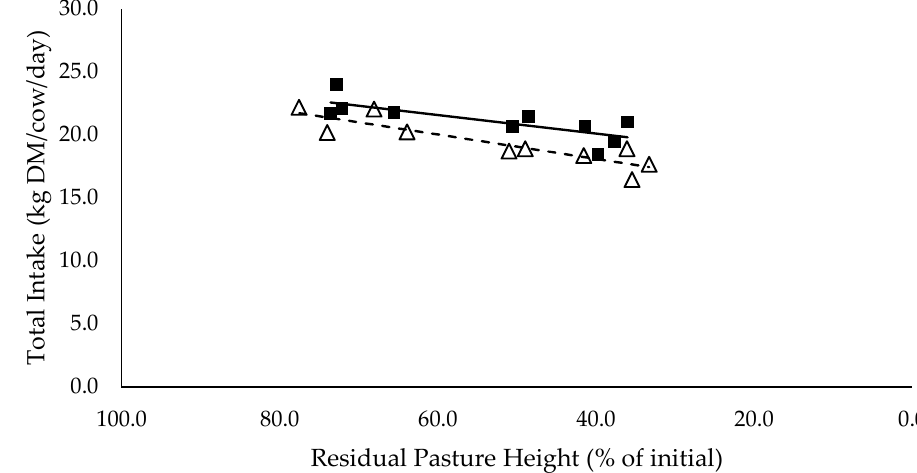
Figure 2. The relationship between total intake (kg DM/cow/day) and residual pasture height (% of initial) for high ( ■ ) and low (Δ) mixed ration levels. Lines were fitted for high (solid) and low (dashed) mixed ration levels.